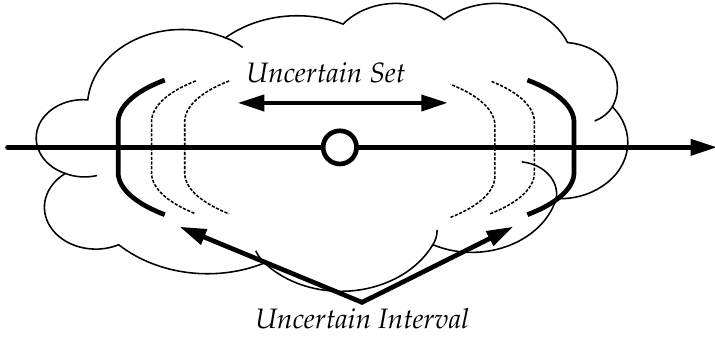
Figure 4. Representation of uncertainties in the information gap theory. Table 5. Main applications of Information Gap